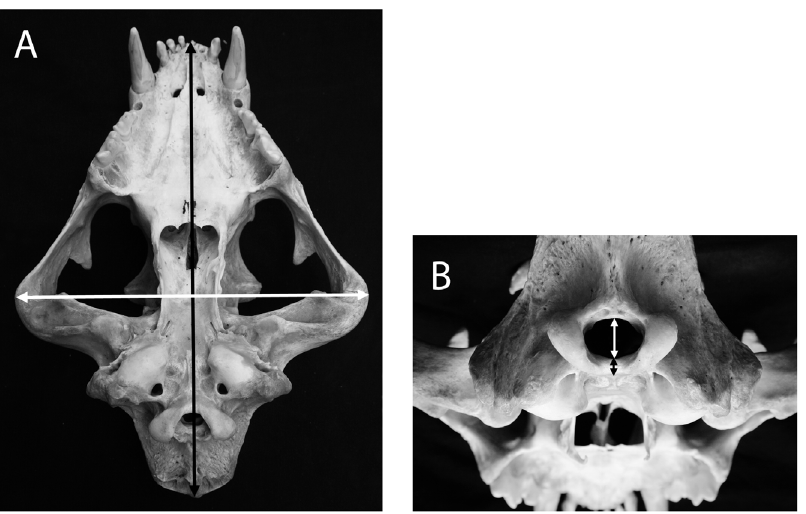
Figure 1. A - The distance between the posthion and the inion - skull length (SL) - black arrow. The distance between the left and right zygomatic arches - skull width (SW) - white arrow. B - The distance between the top of the basilar part of the occipital bone and the bottom of the occipital bone - foramen magnum height (FMH) – white arrow. The distance between the bottom and the top of the basilar part of the occipital bone at its most caudal aspect - basilar thickness (BT) – black arrow.